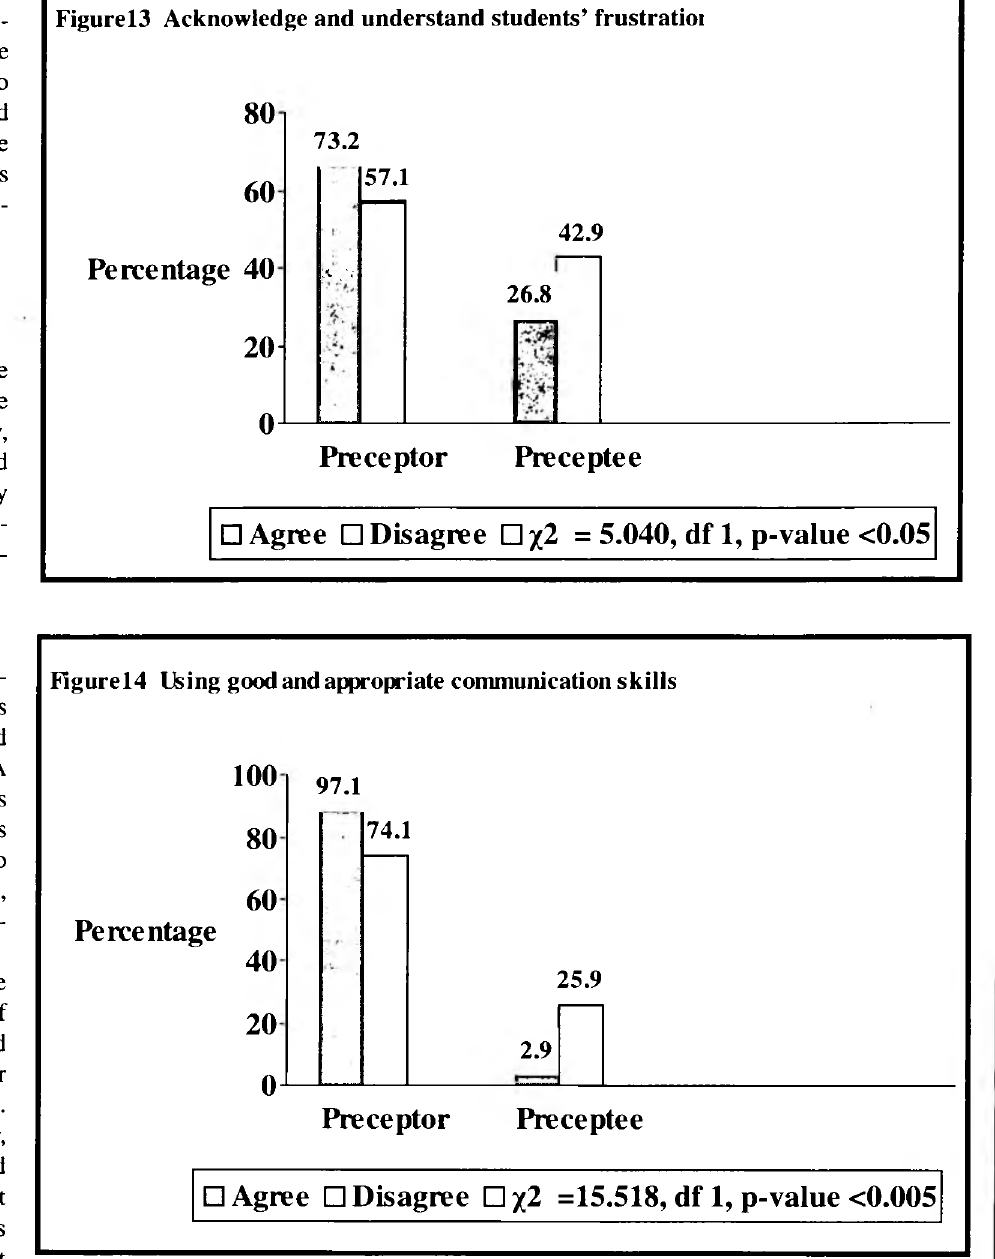
Figurel4 Using good and appropriate communication